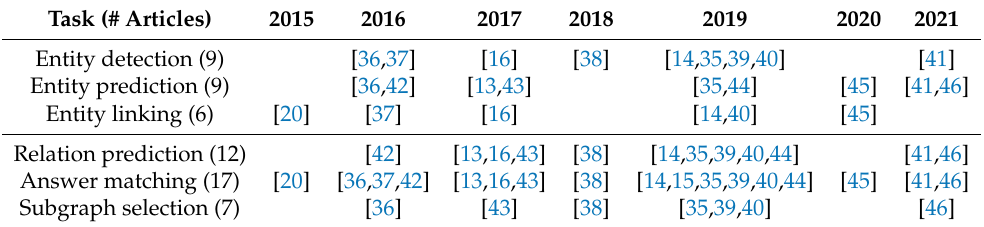
Table 1. Published articles per KGSQA task per year. Some articles proposed solutions to multiple